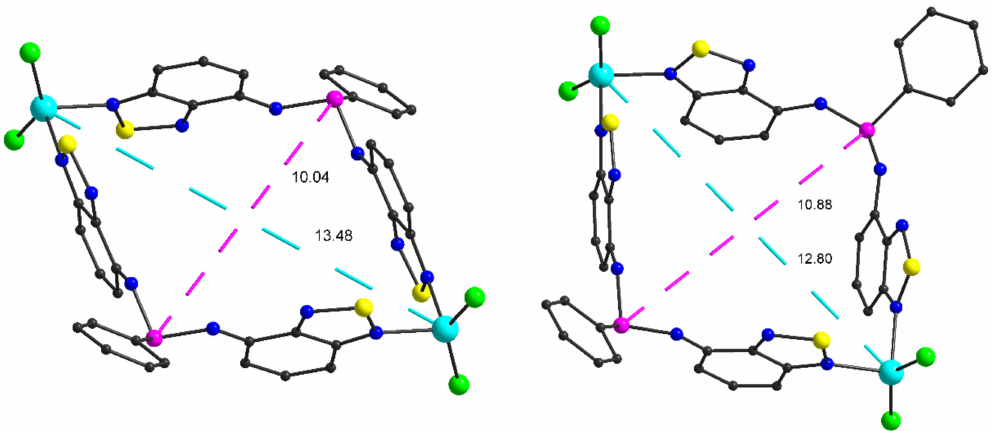
Figure 6. Arrangement of toluene molecules inside the cavity of 2a · 3C 7 H 8 and 2b · 2.5C 7 H 8 (top). DFT-optimized molecules of 2a and 2b (bottom). Hydrogen atoms are omitted.